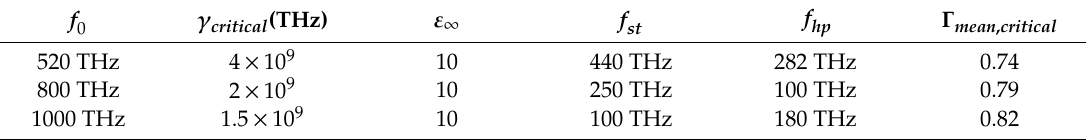
Table 3. Critical (threshold) values of the polarization damping coe ffi cient γ and the mean reflection coe ffi cient Γ mean for high gain amplification of the input (stimulus)